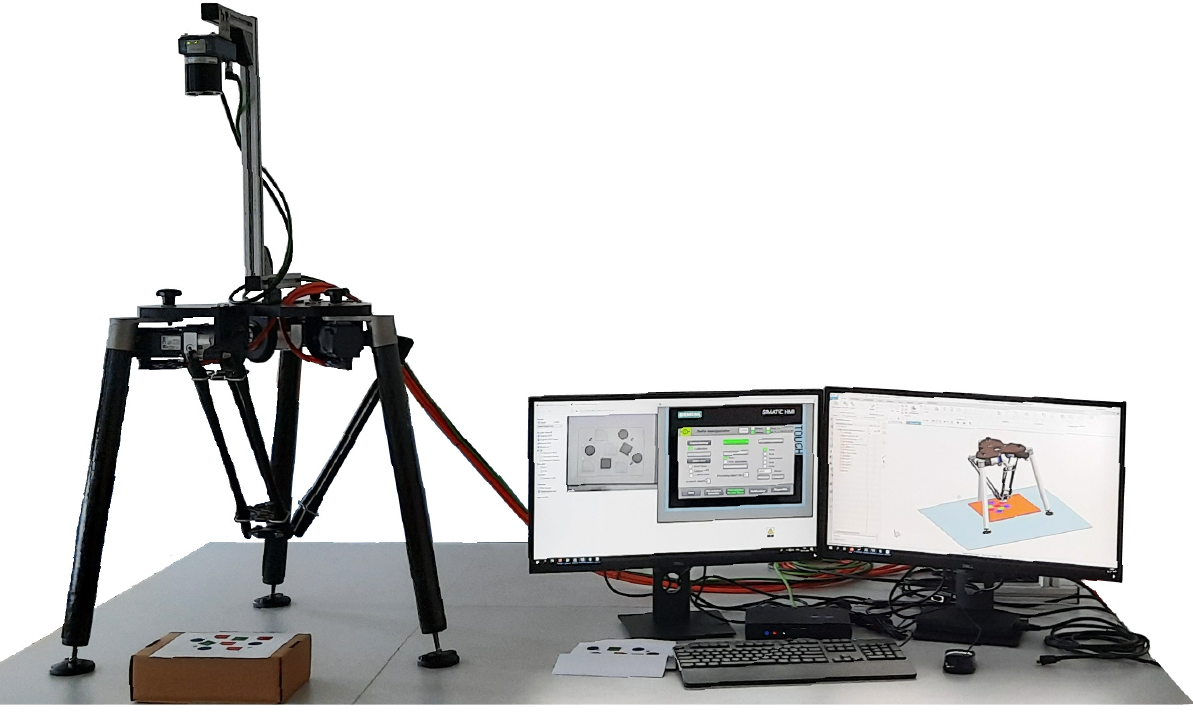
Figure 16. Real, partially implemented delta robot manipulator and its digital twin implemented in NX